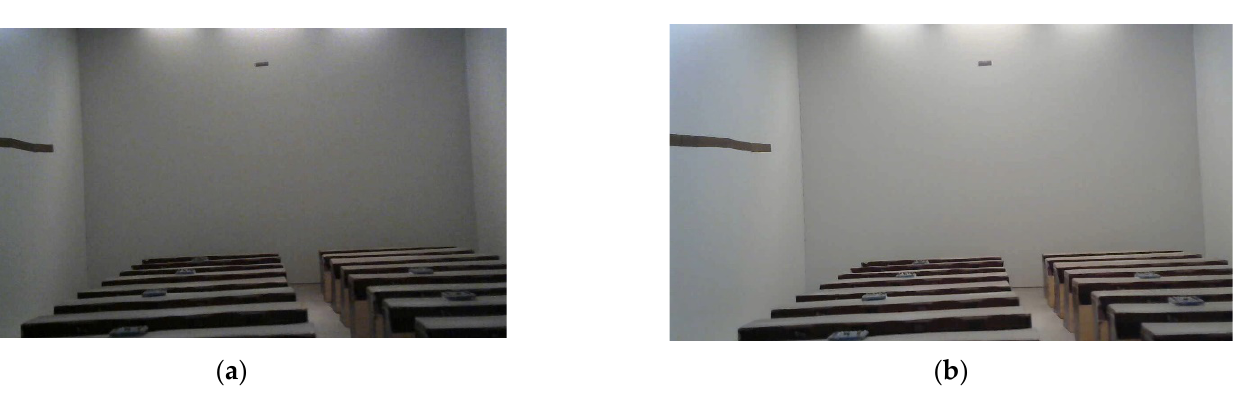
Figure 16. Qualitative comparative analysis of daylighting levels: ( a ) inside the scale model without heliostat illuminators; ( b ) the one with heliostat illuminators. For quantitative analysis, the lighting levels recorded by each luxmeter inside both models were compared (Figure 17).